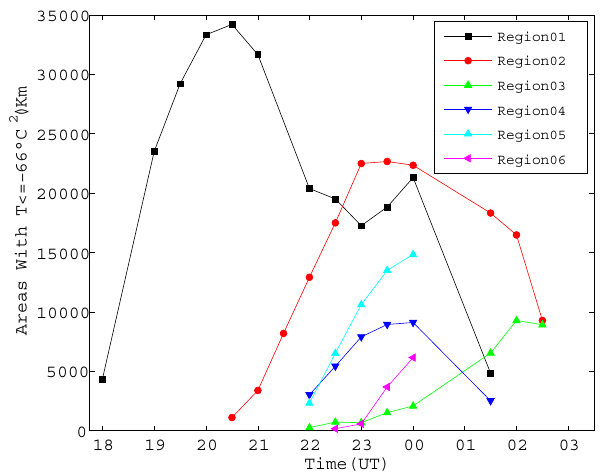
Fig. 5. Overall cloud cover ( T < − 66 ◦ C) temporal evolution of